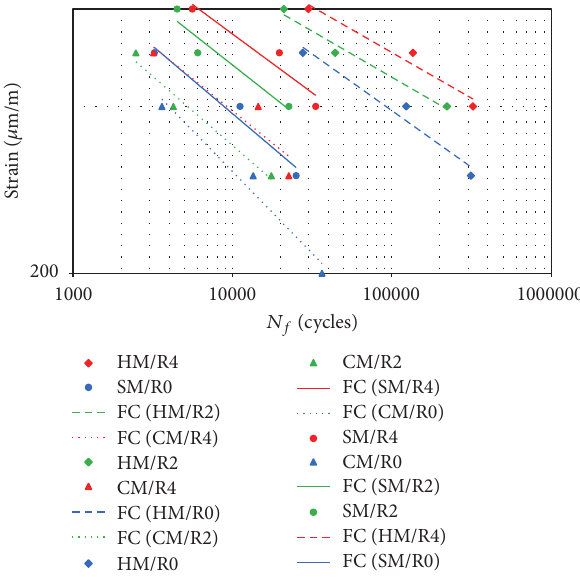
Figure 5: Fatigue life 𝑁 𝑓 versus initial strain: aged mixes.